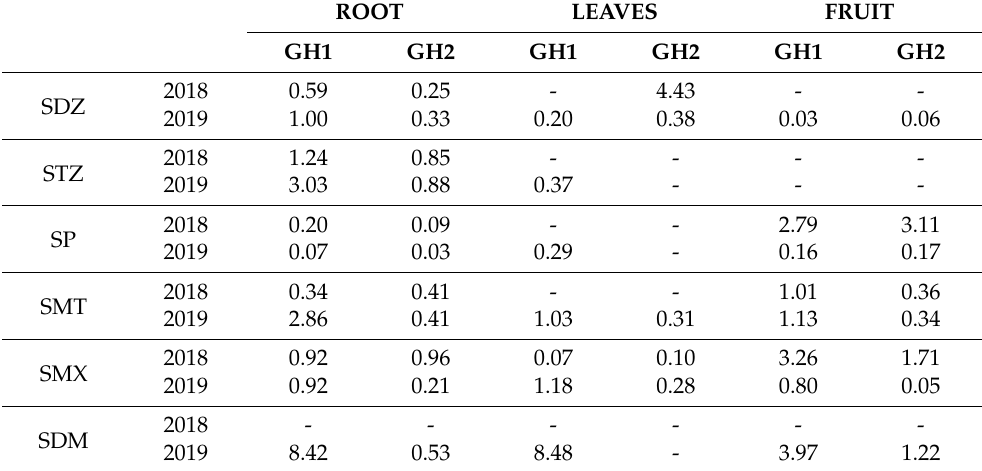
Table 7. Bioconcentration factor (BCF) of sulfonamides (sulfadiazine (SDZ), sulfathiazole (STZ), sulfapyridine (SP), sulfamethizole (SMT), sulfamethoxazole (SMX) and sulfadimethoxine (SDM)) in the tomato plants from two commercial greenhouses in 2018 and